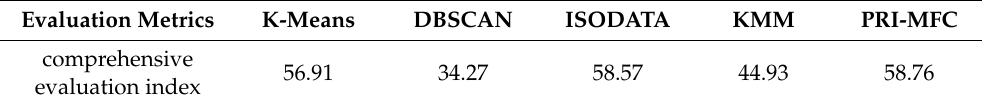
Table 9. The weighted averages of comprehensive evaluation index of five algorithms (%).